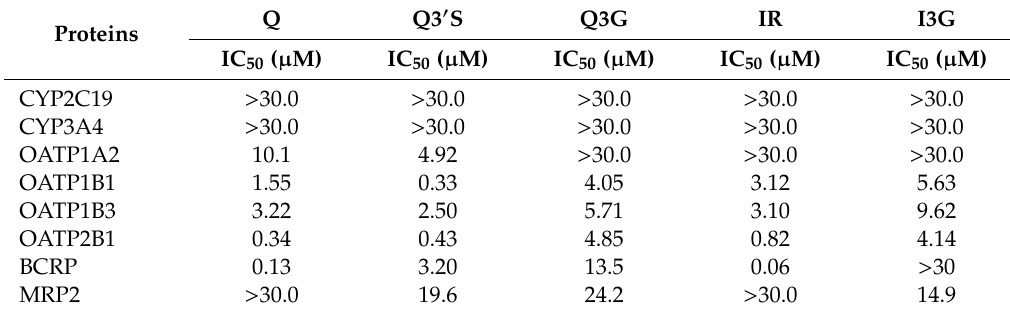
Table 1. IC 50 values of flavonoids for CYP2C19, CYP3A4, OATPs, BCRP, and